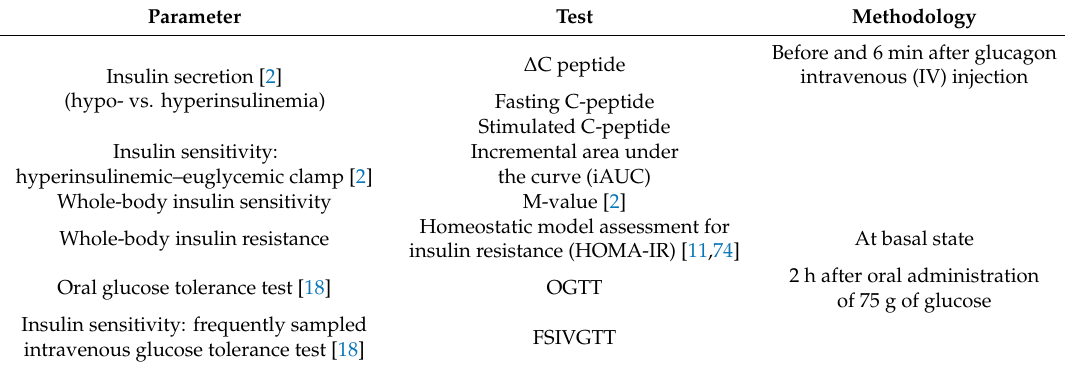
Table 3. Measures of insulin secretion and